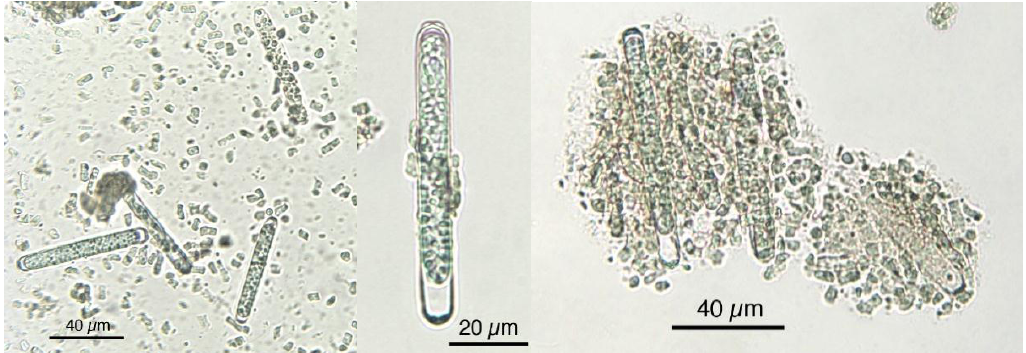
Figure 4. Microphotographs of Klamath power showing fragmented as well as intact cells with resistant cell wall and characteristic form.